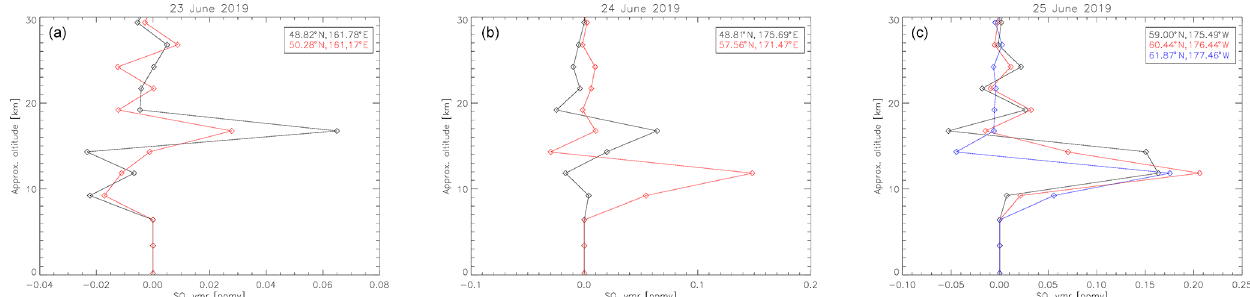
Figure 15. MLS SO 2 profiles measured on 23 June 2019 ( a , overpass at around 02:20UTC), 24 June 2019 ( b , overpass at around 01:30UTC), and 25 June 2019 ( c , overpass at around 00:30UTC), in the extended volcanic plume from the Raikoke eruption, clearly showing the presence of an SO 2 layer at an altitude of around 17km on 23 June, two distinct layers at 12 and 17km at different positions of the plume on 24 June 2019, and around 12–14km on 25 June 2019. The position of the measurements is shown in Fig.